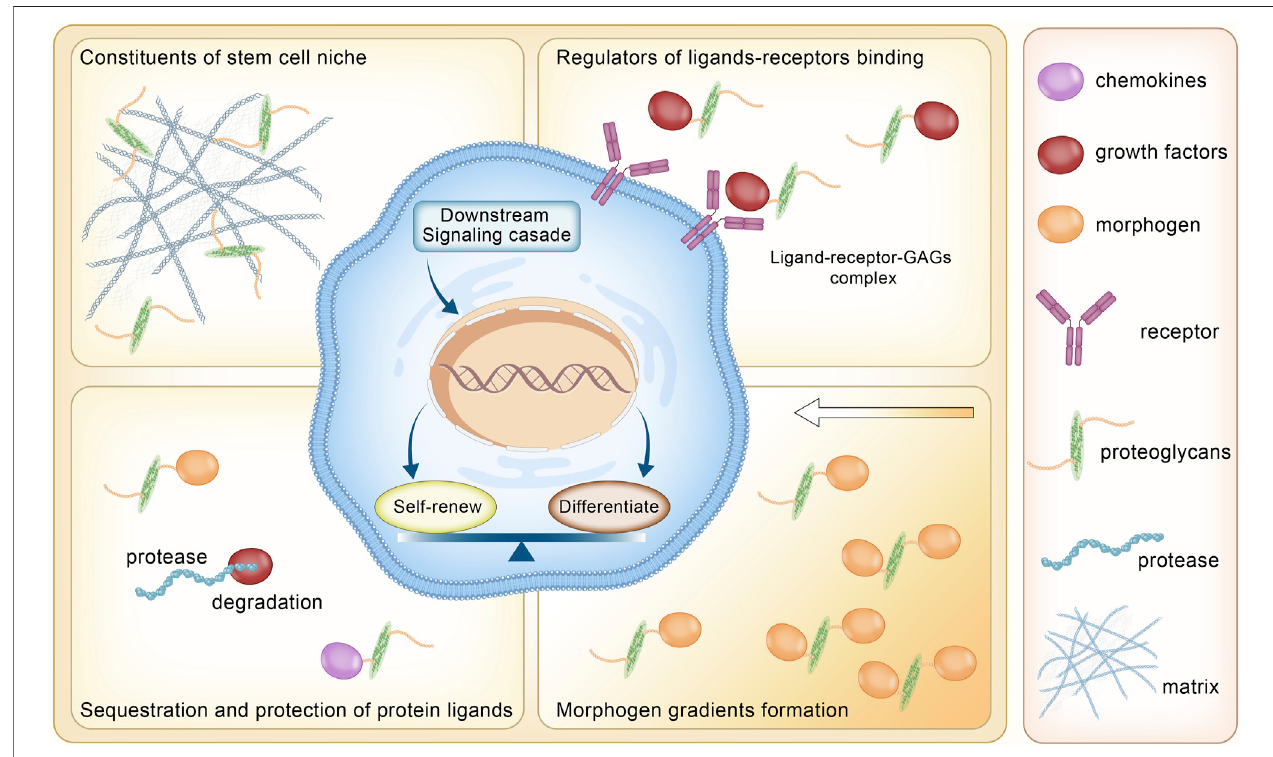
FIGURE 3 | Roles of proteoglycans in stem cell